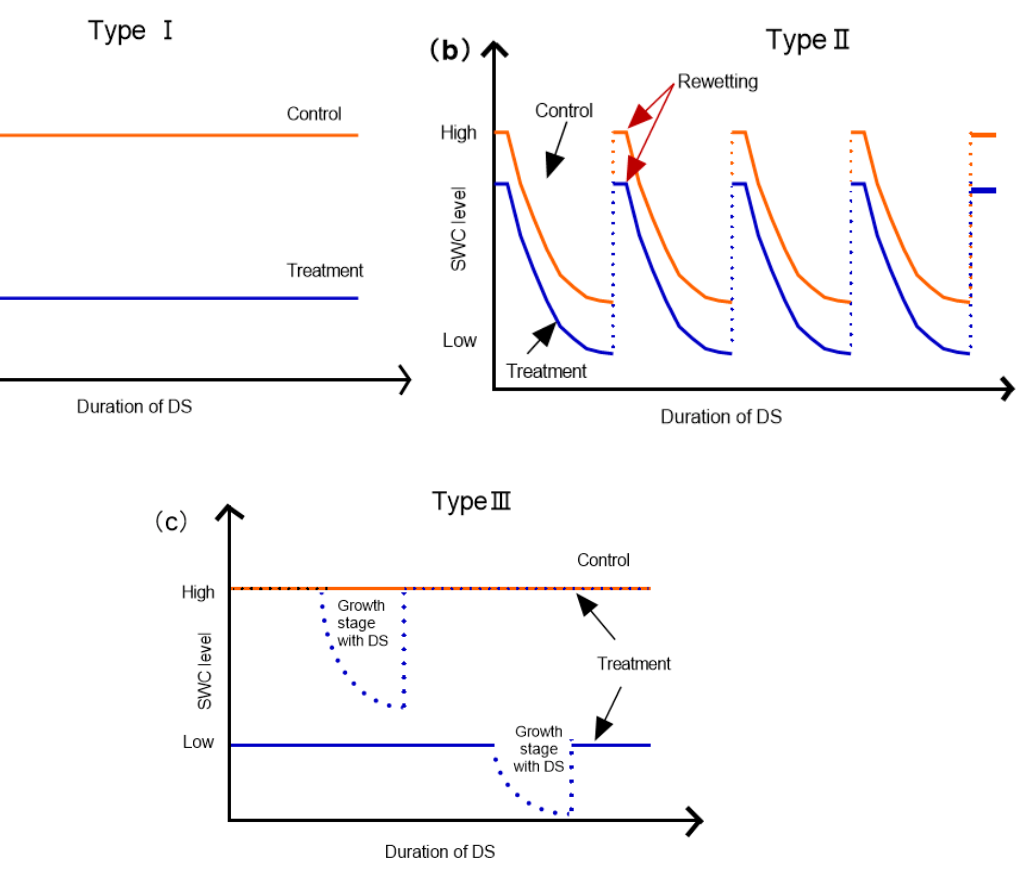
Figure 7. Drought stress (DS) manipulation type used in the meta-analysis. We classified